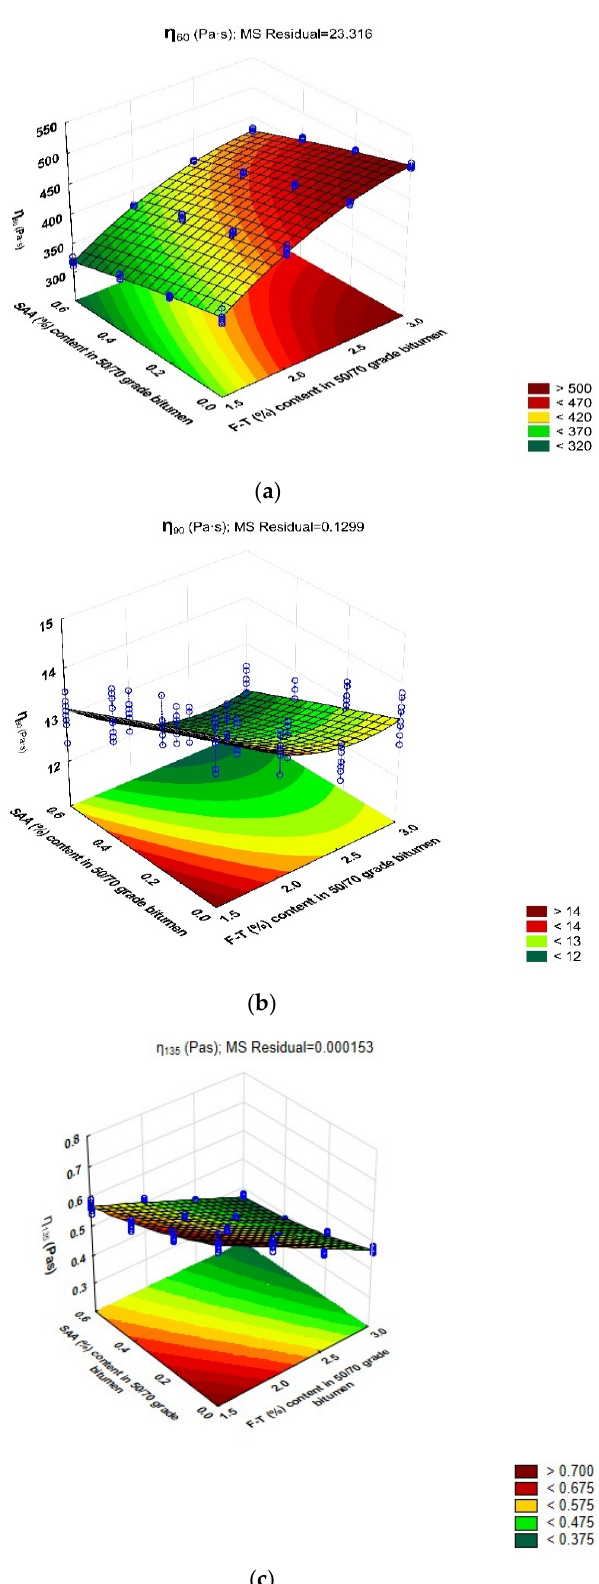
A graphical interpretation of the dynamic viscosity change with respect to F–T wax and SAA contents is represented as response surface plots in Figure 18.